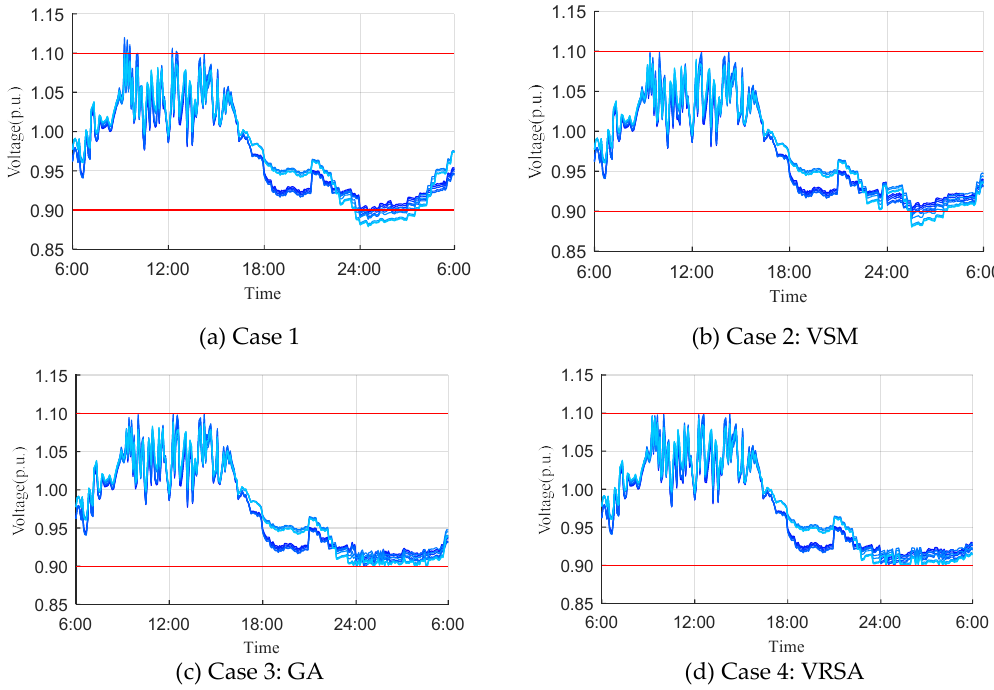
Figure 12. Voltage condition of the four cases. VSM—voltage sensitivity method; GA–genetic algorithm.